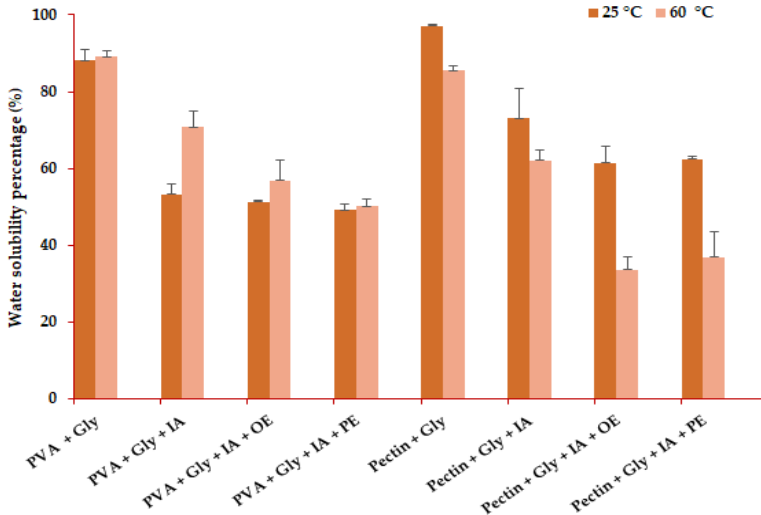
Figure 5. The results obtained for water solubility of the PVA and pectin-based biofilms, enriched with IA, organic extract and phenolic extract. PVA-PolyVinyl Alcohol, IA-Itaconic Acid, Gly—glycerol, OE—organic Extract, PE—Phenolic Extract. The results are expressed as mean values (±SD).